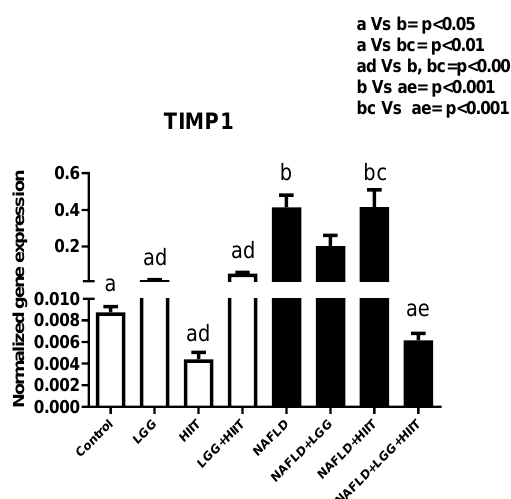
Figure 3: Liver tissue inhibitor matrix metallopro- teinase 1 ( TIMP 1) mRNA expression in different groups of study. All values are the mean ± SD (n = 10 per group). Values with different superscripts are significantly different, p < 0.05. LGG: Probiotic L. rhamnosus GG, HIIT: High intensity interval training, NAFLD: Non-alcoholic fatty liver disease MMP-2 mRNA